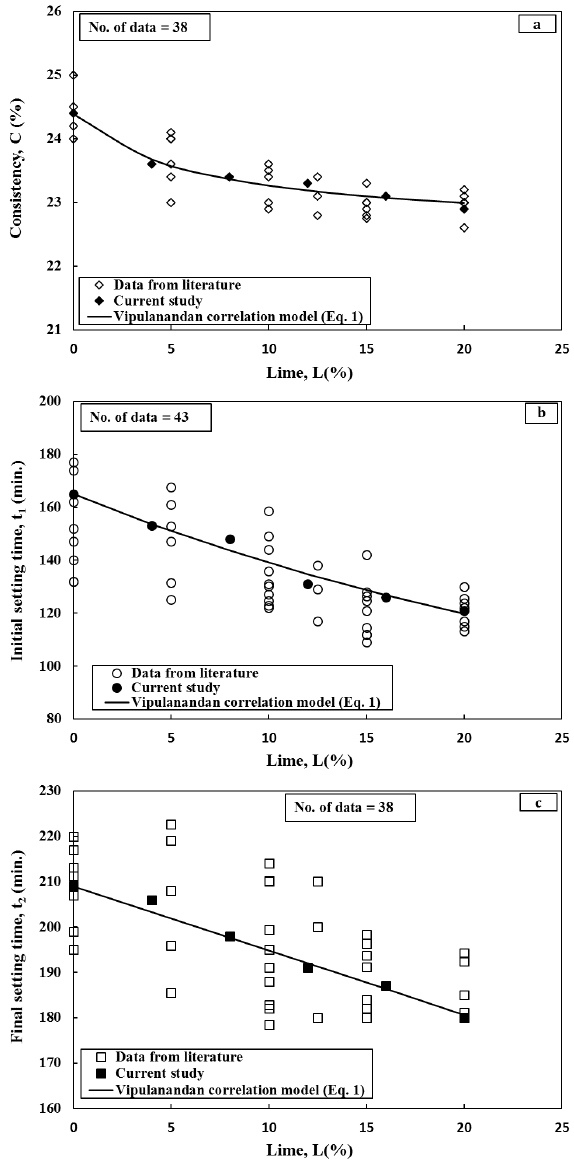
Figure 8: Relationship between percentage of lime and (a) Consis- tency (b) Initial setting time and (c) Final setting time of cement paste